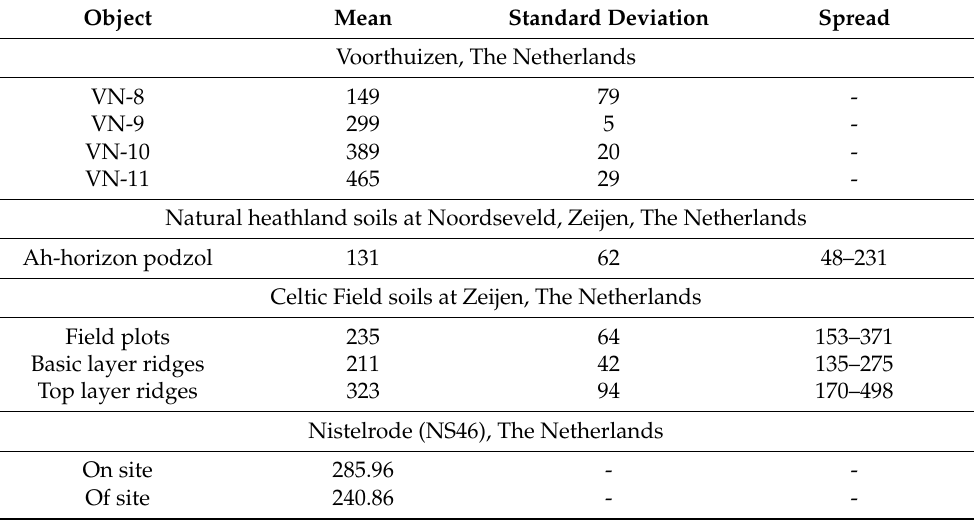
Top layer ridges On